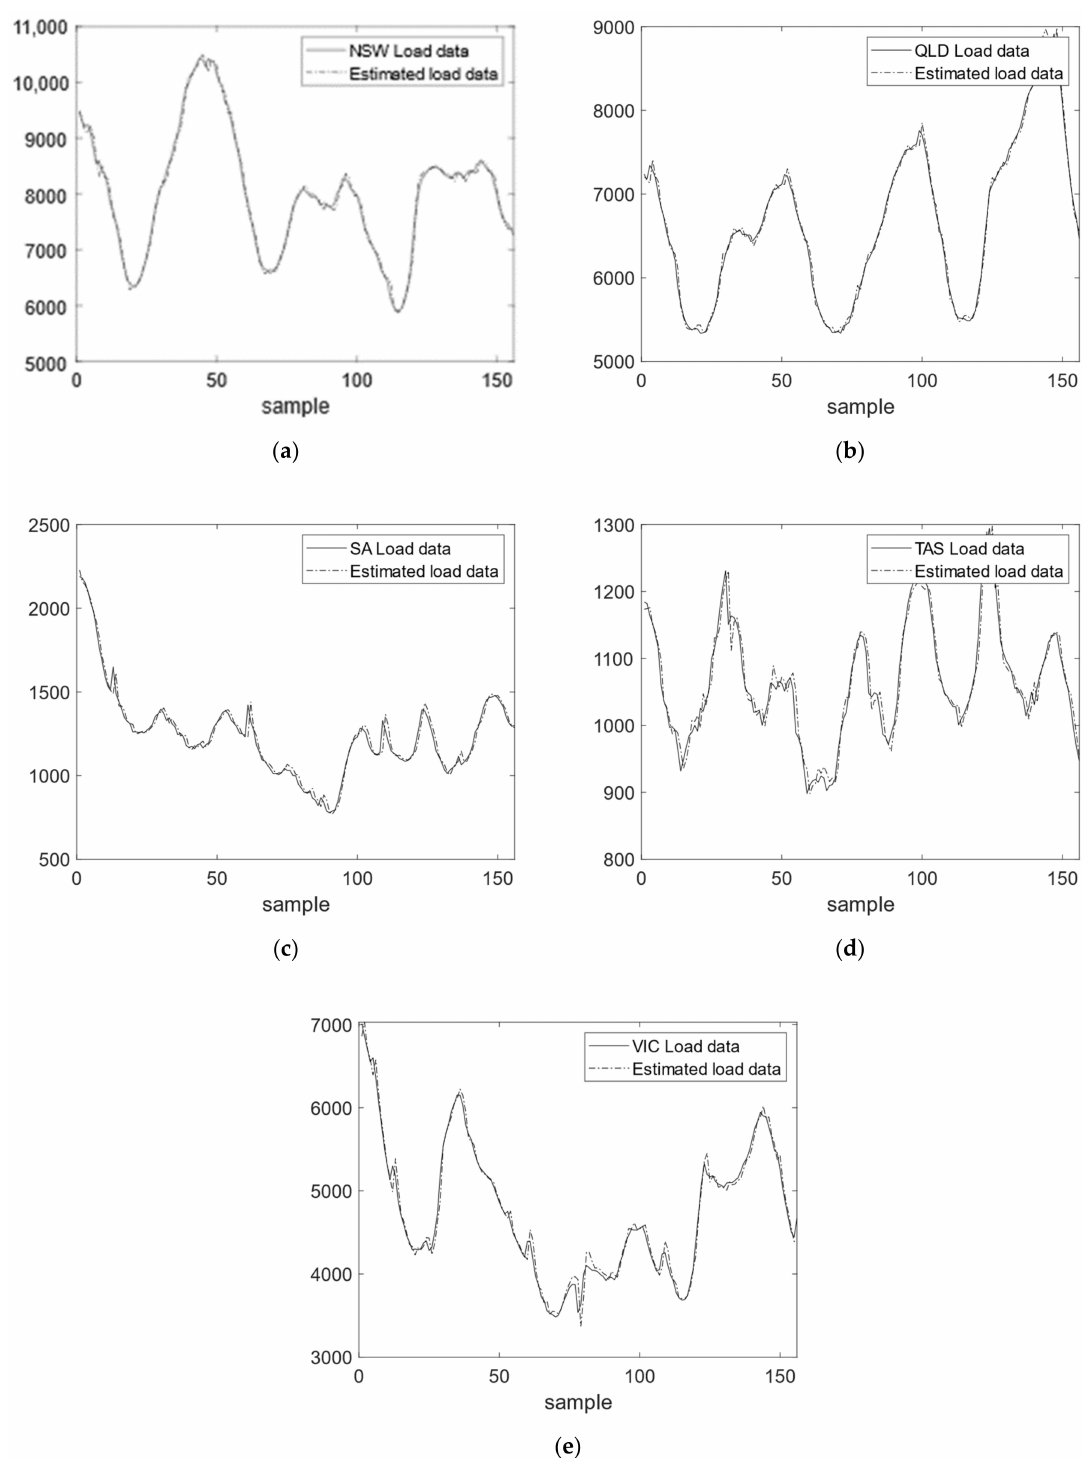
Figure 8. Estimation performance of the proposed prediction method for five regions of Australia electrical load dataset (train set): ( a ) NSW, ( b ) QLD, ( c ) SA, ( d ) TAS, ( e )